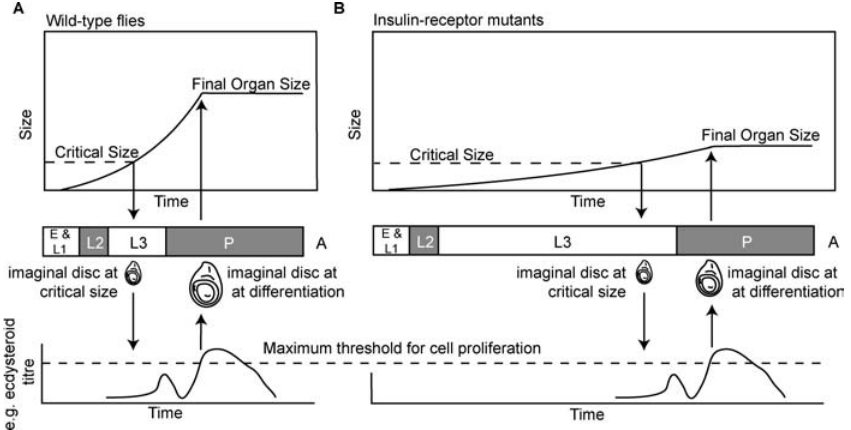
Figure 7. A Model of the Insulin-Signaling Regulation of Growth and Development (A) Under normal conditions, imaginal discs grow to a critical size, which initiates an increase in the ecdysteroid titer. When ecdysteroid levels rise above a maximum threshold, the discs cease cell proliferation and undergo differentiation, fixing their final size. A, adult; E, embryo; L1–L3, first to third larval instar; P, pupa. (B) In Inr mutants, growth of imaginal discs to critical size is slowed, retarding development. When critical size is reached, the ecdysteroid titer again increases, rising above the maximum threshold for cell proliferation in the imaginal discs. Temporal changes in the ecdysteroid titer are unaffected by insulin signaling. Because the rate of cell proliferation is slowed, the imaginal discs are smaller when they begin to differentiate, reducing final organ size. Different discs have different thresholds of sensitivity to ecdysteroid and so cease cell proliferation at different times. Hormones other than ecdysteroids may also be involved. DOI: